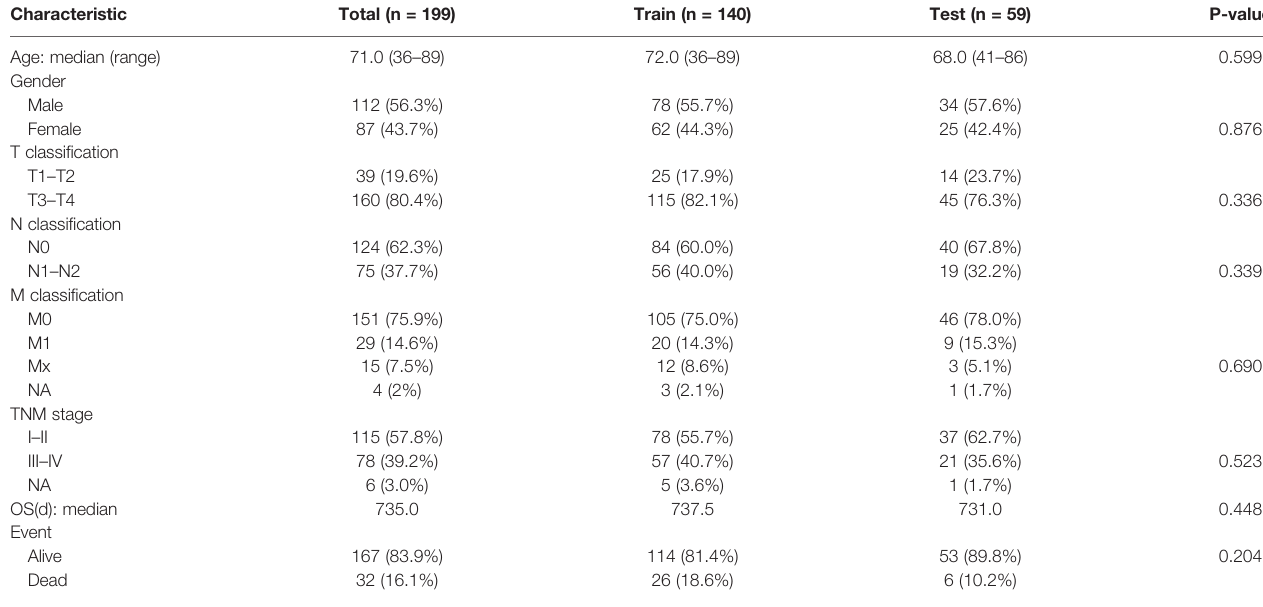
TABLE 1 | Demographic and clinical characteristics of